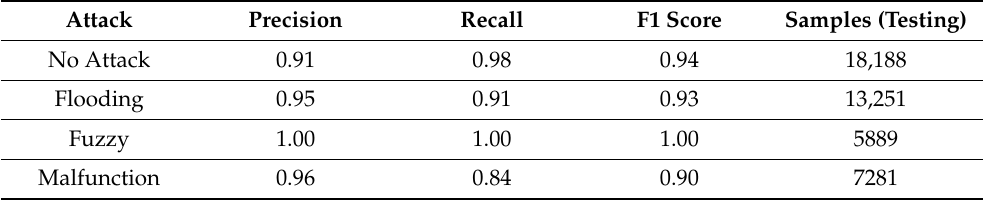
Figure 10. Confusion Matrix of DT (Dataset 2). Table 7. Detection performance of flooding, fuzzy, malfunction, and attack-free for DT (Dataset 2). Attack